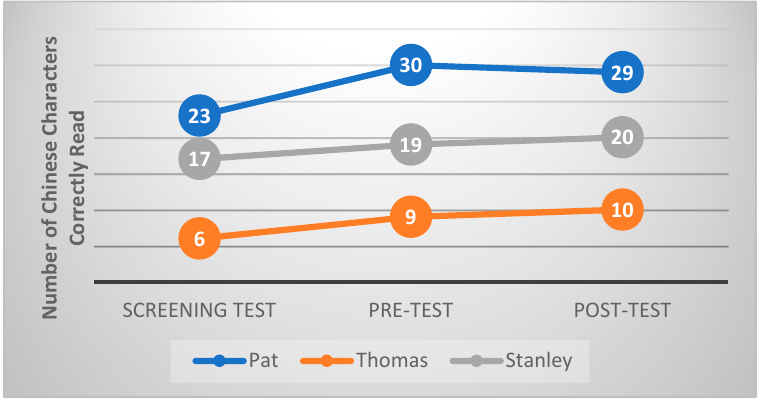
Figure 3. The characters read correctly by each child across all time points.